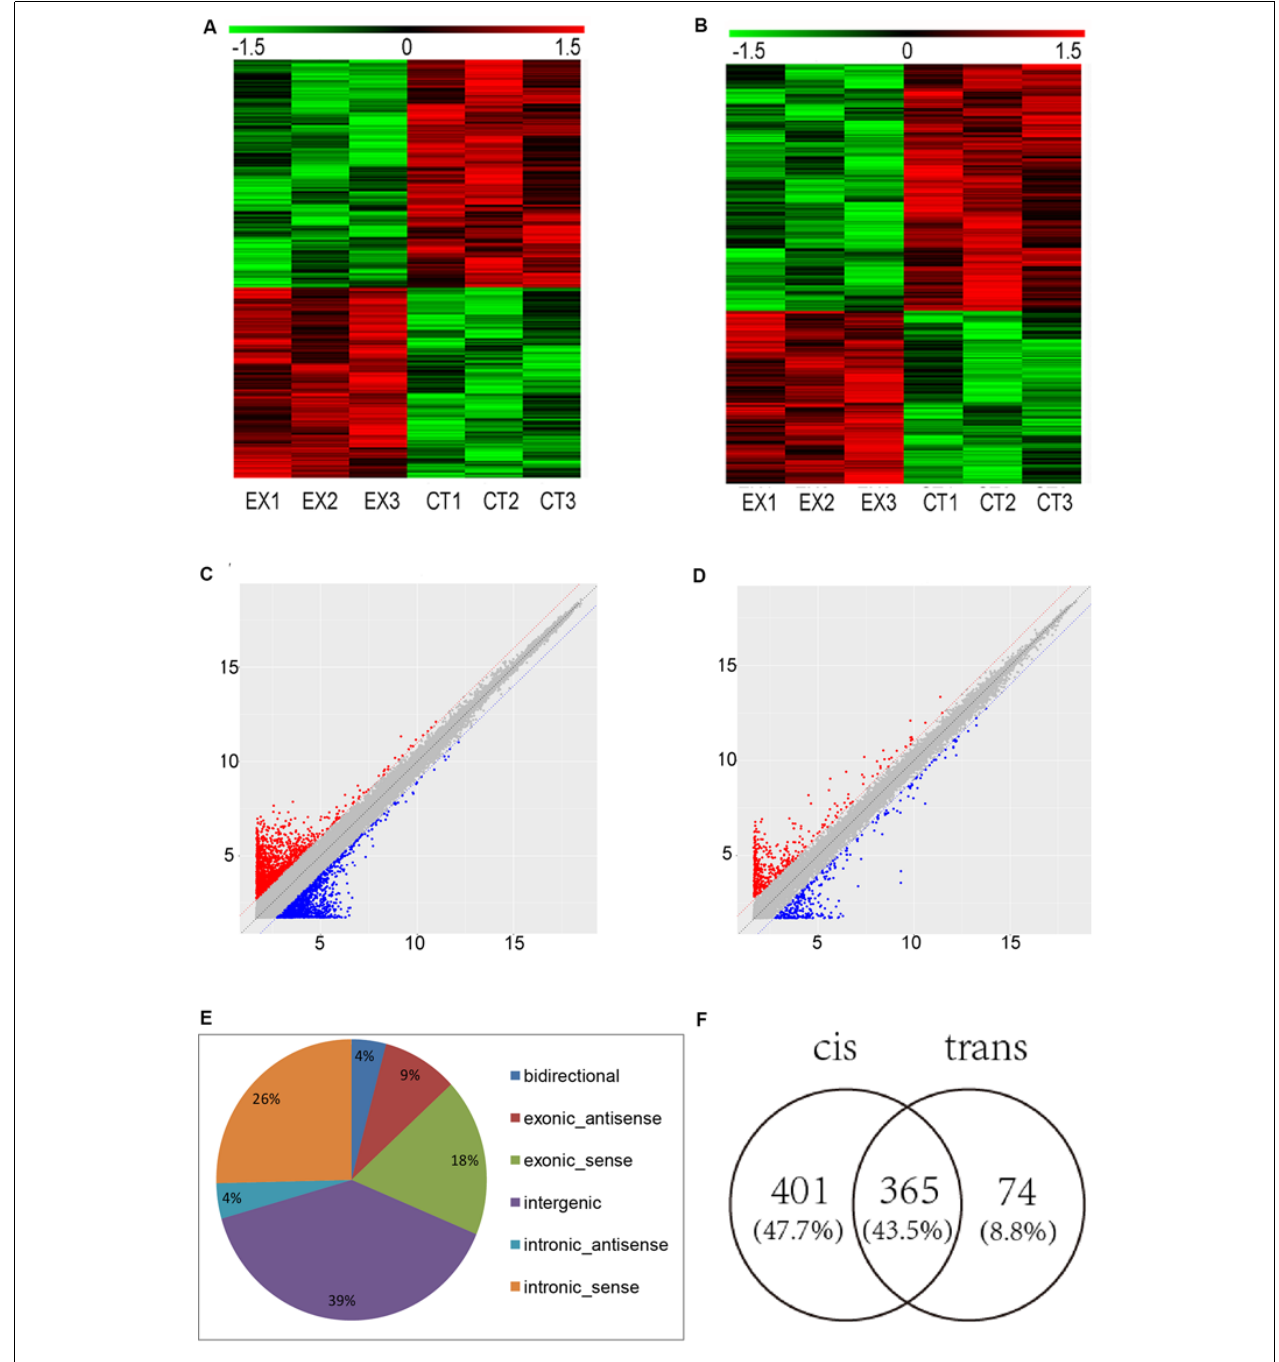
FIGURE 1 | Microarray analysis for long non-coding RNAs (lncRNAs) and mRNAs expression in the brains of mice infected with T. gondii Chinese1 Wh 6 strain. (A) Hierarchical clustering of differentially expressed lncRNAs in the brain of mice infected and uninfected with T. gondii . Values in the color scale are normalized intensities. Red bands indicate high relative expression and green bands indicate low relative expression. (B) Hierarchical clustering of differentially expressed mRNAs in the brain of mice infected and uninfected with T. gondii . Values in the color scale are normalized intensities. Red bands indicate high relative expression and green bands indicate low relative expression. (C) Volcano Scatter plot filtering was used to visualize fold regulation and statistical significance in lncRNA populations in mice brains. Statistically significant ( p ≤ 0.05) up (red) or down (blue) regulated expression changes ( > 2-fold) are shown in pair-wise comparisons of T. gondii infected and uninfected mice brains. (D) Volcano Scatter plot filtering was used to visualize fold regulation and statistical significance in mRNAs populations in mice brains. Statistically significant ( p -value ≤ 0.05) up (red) or down (blue) regulated expression changes ( > 2-fold) are shown in pair-wise comparisons of T. gondii infected and uninfected mice brains. (E) Classification of dysregulated lncRNAs in the brain of mice infected by T. gondii . (F) Venn diagram of the target genes of dysregulated lncRNAs using cis and trans analysis.